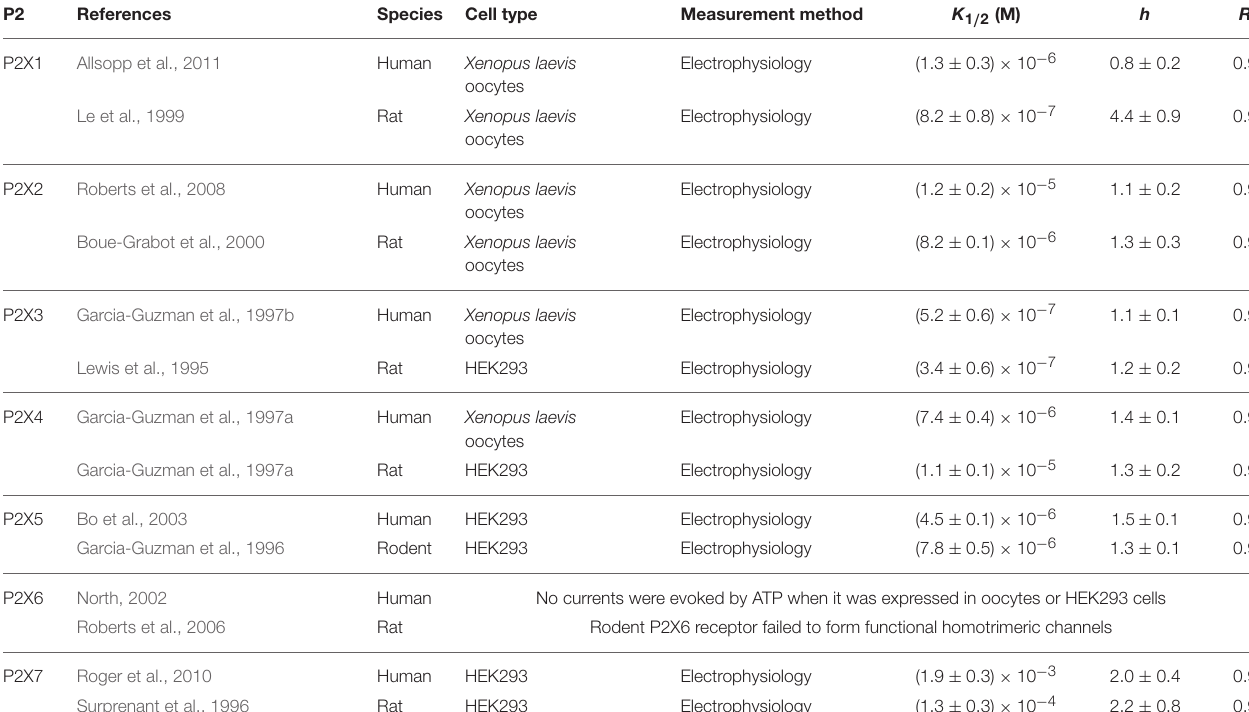
TABLE 1 | P2X Receptors: data sources and fitting parameters. P2